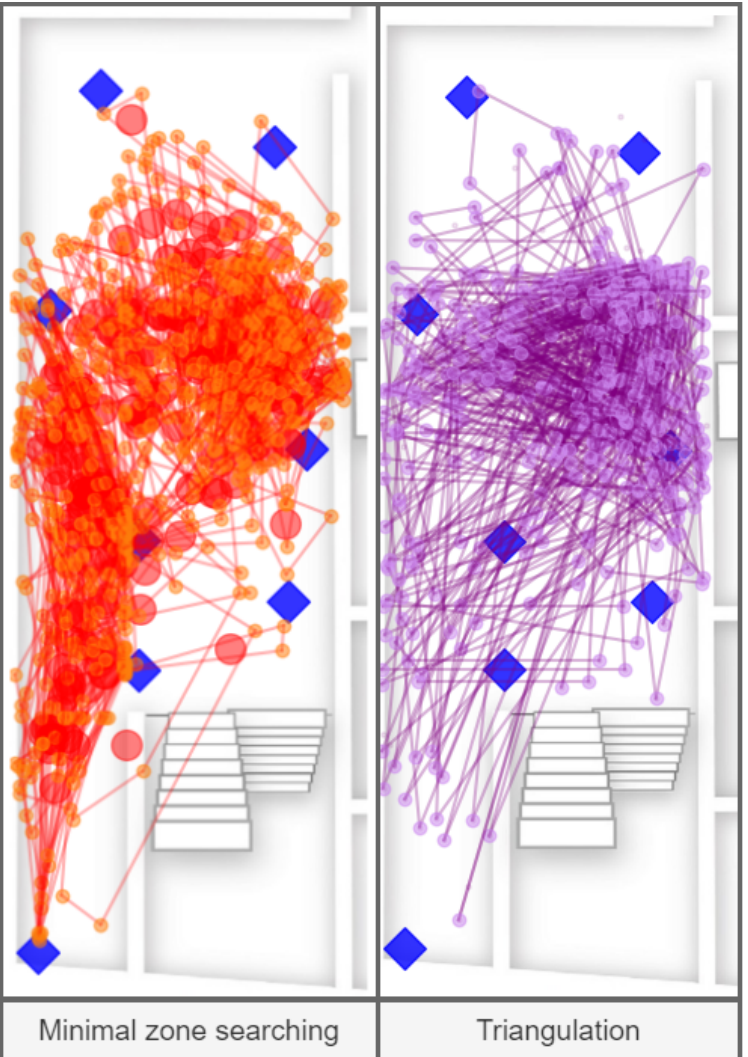
Figure 11. Visual comparison between triangulation and MZS , with data from tag number 8 in DS2